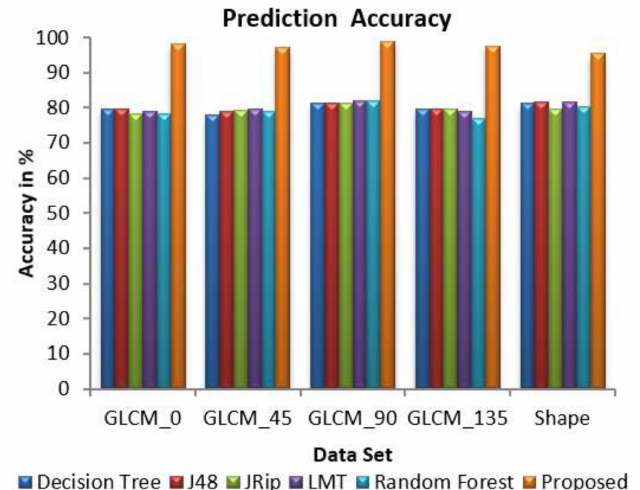
Figure 7. Comparison of overall prediction accuracies.